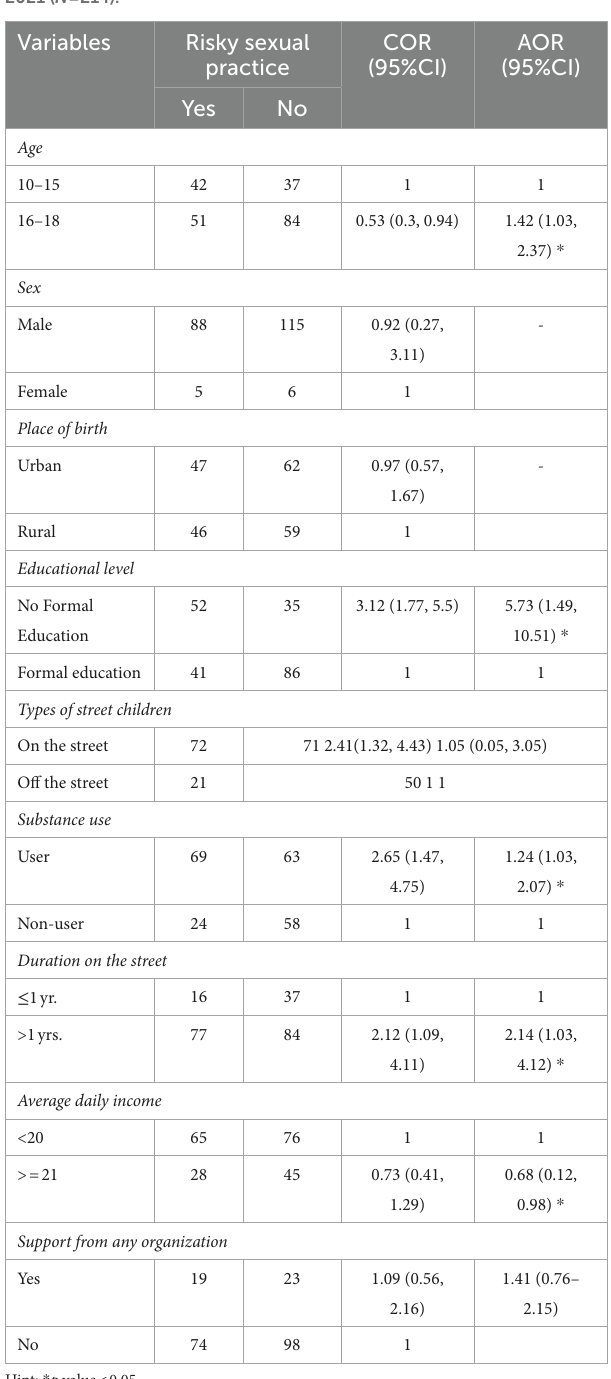
TABLE 5 Bivariate and multivariate analyses of factors associated with risky sexual practice among street children in Wonago town, September 2021 ( N =